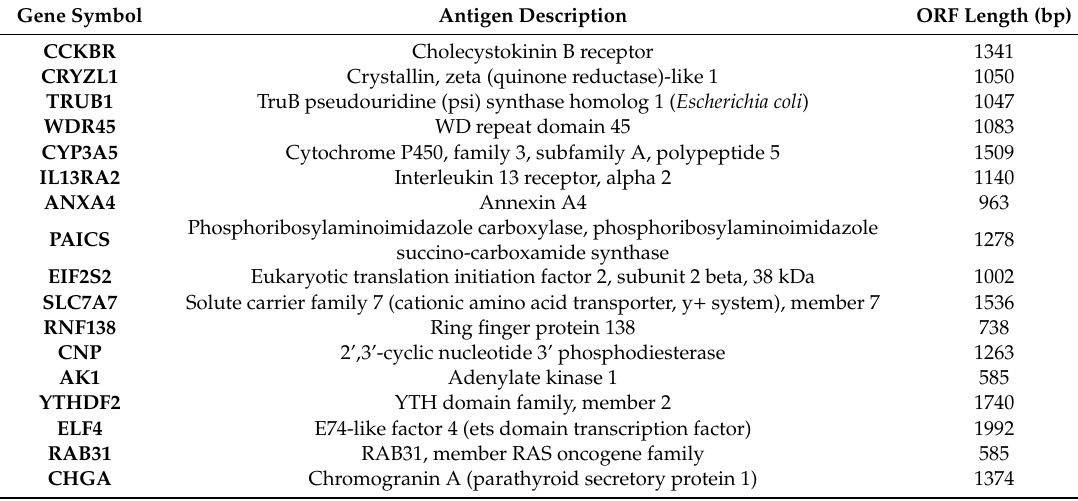
Table 2. Characterization of the selected 29 autoantigens for individual